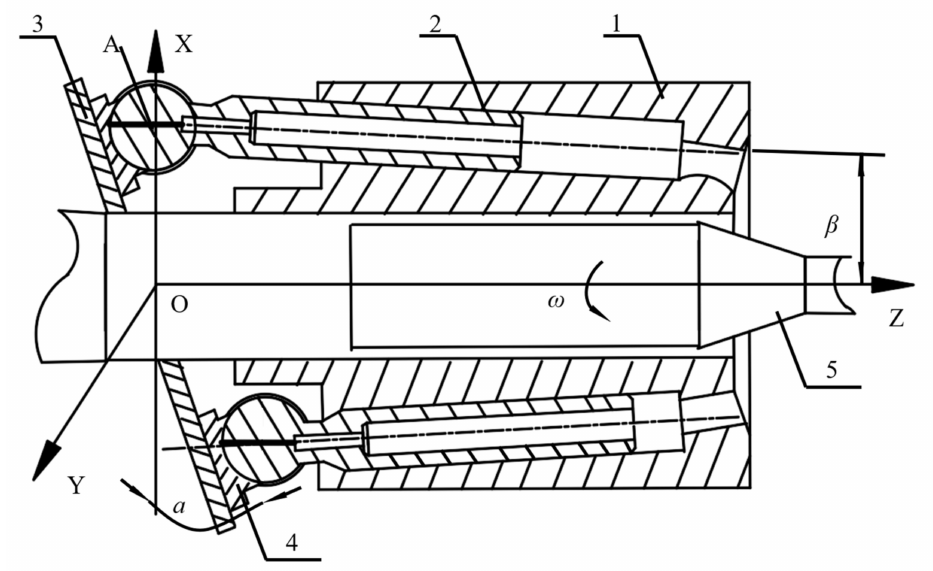
Figure 3. Conical piston-pump structure diagram: 1. Cylinder block, 2. Plunger, 3. Swashplate,